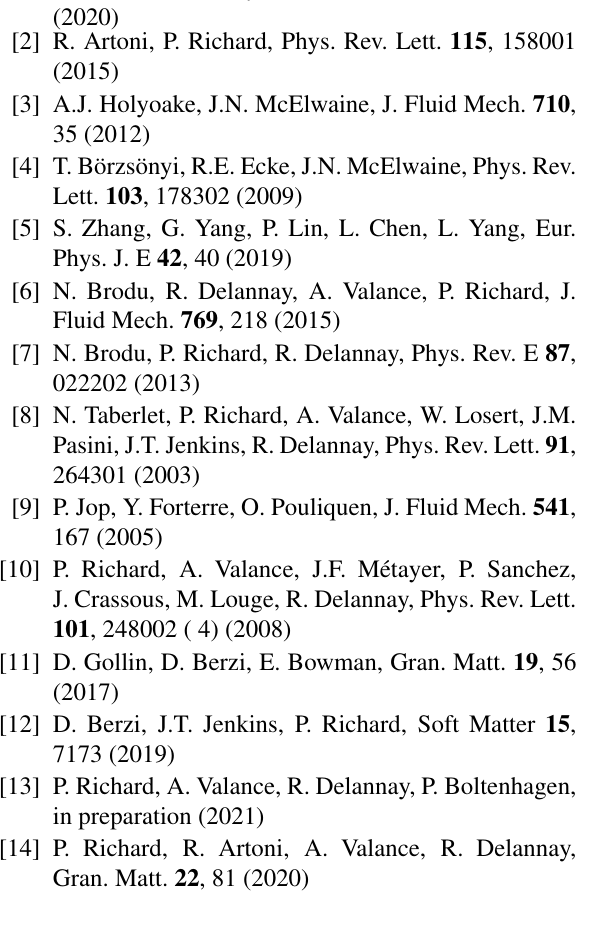
(cid:112) σ w /ρ ) is found to xx